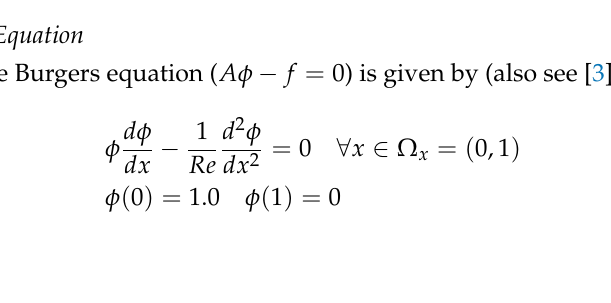
Figure 12. Graphs of I versus dof for convection diffusion